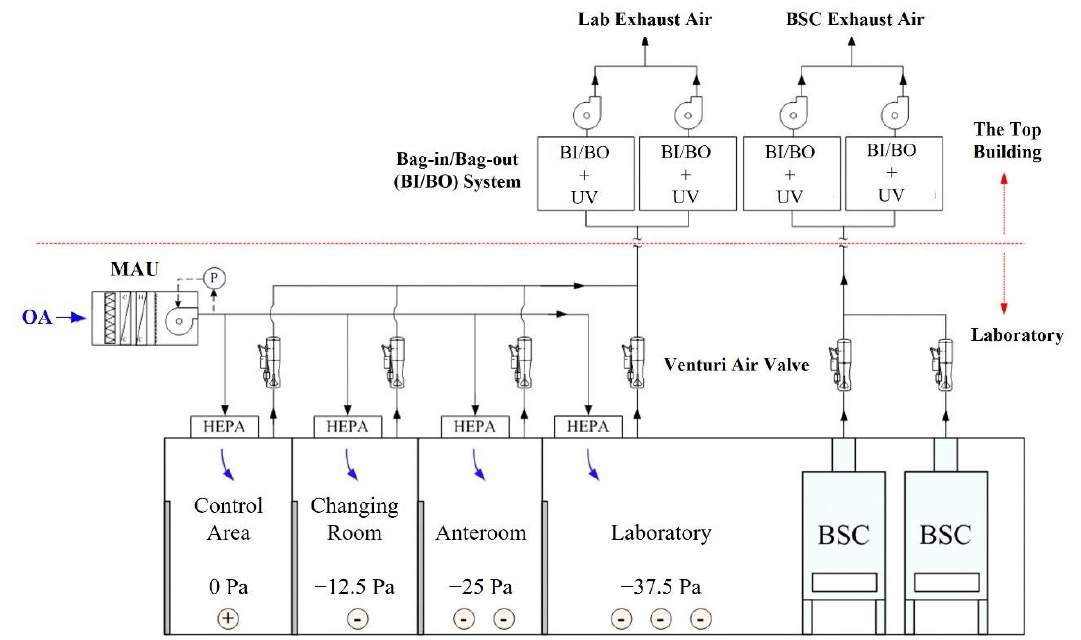
Figure 2. Schematic diagram of the investigated BSL-3 laboratory system.